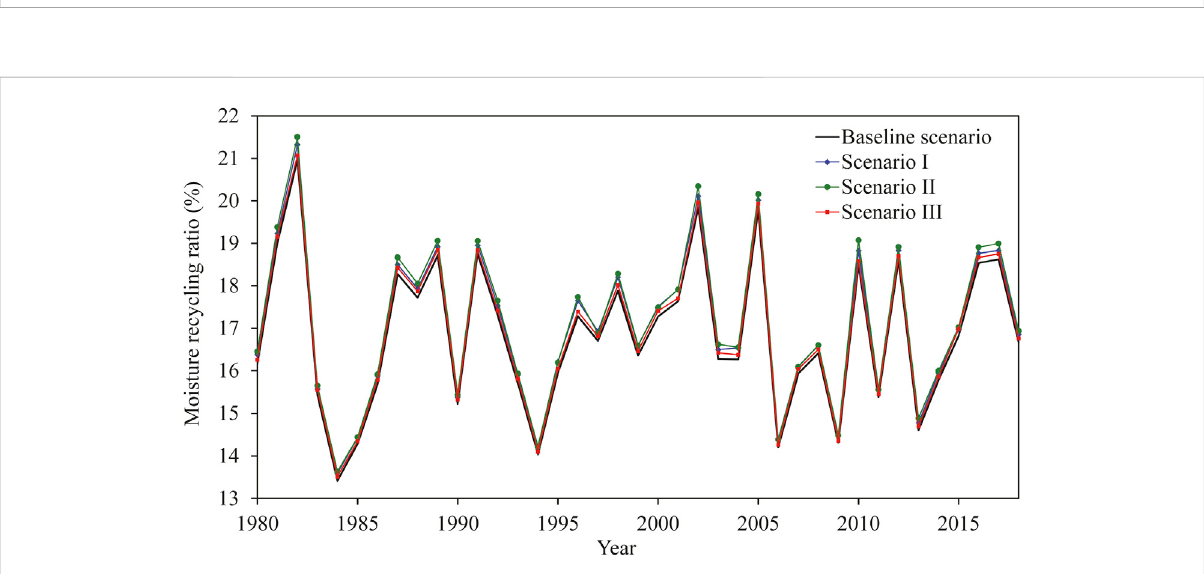
FIGURE 9 Yearly moisture recycling ratio in the Tarim Basin under different